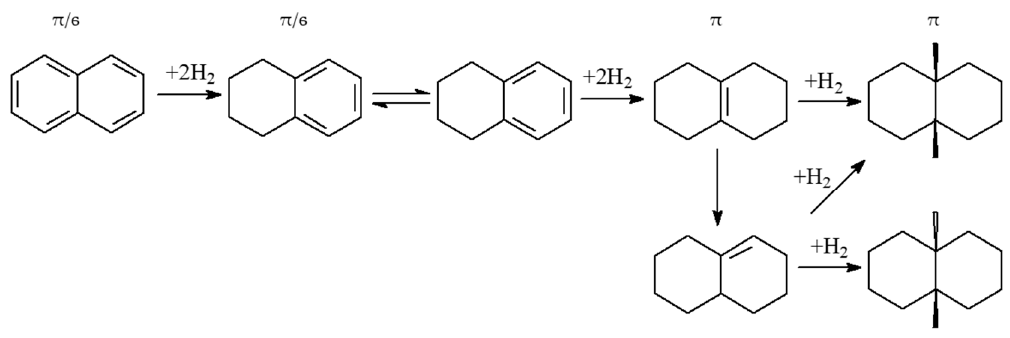
Figure 7. Hydrogenation of